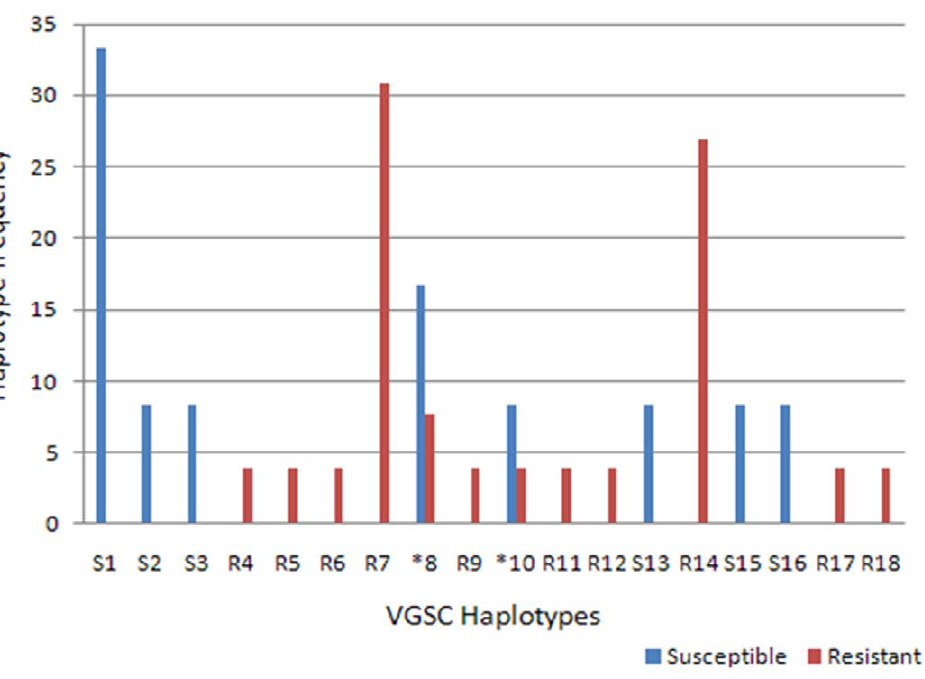
Figure 4. Distribution of the sodium channel gene haplotypes between susceptible and resistant mosquitoes from Tororo.